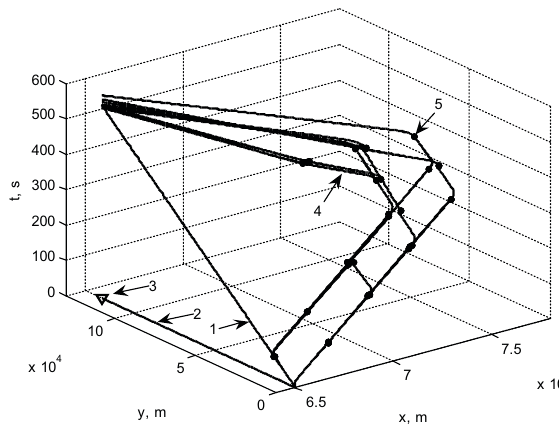
Table 1. Parameters of aircraft flight and the characteristics of the predicted conflict situation Parameters